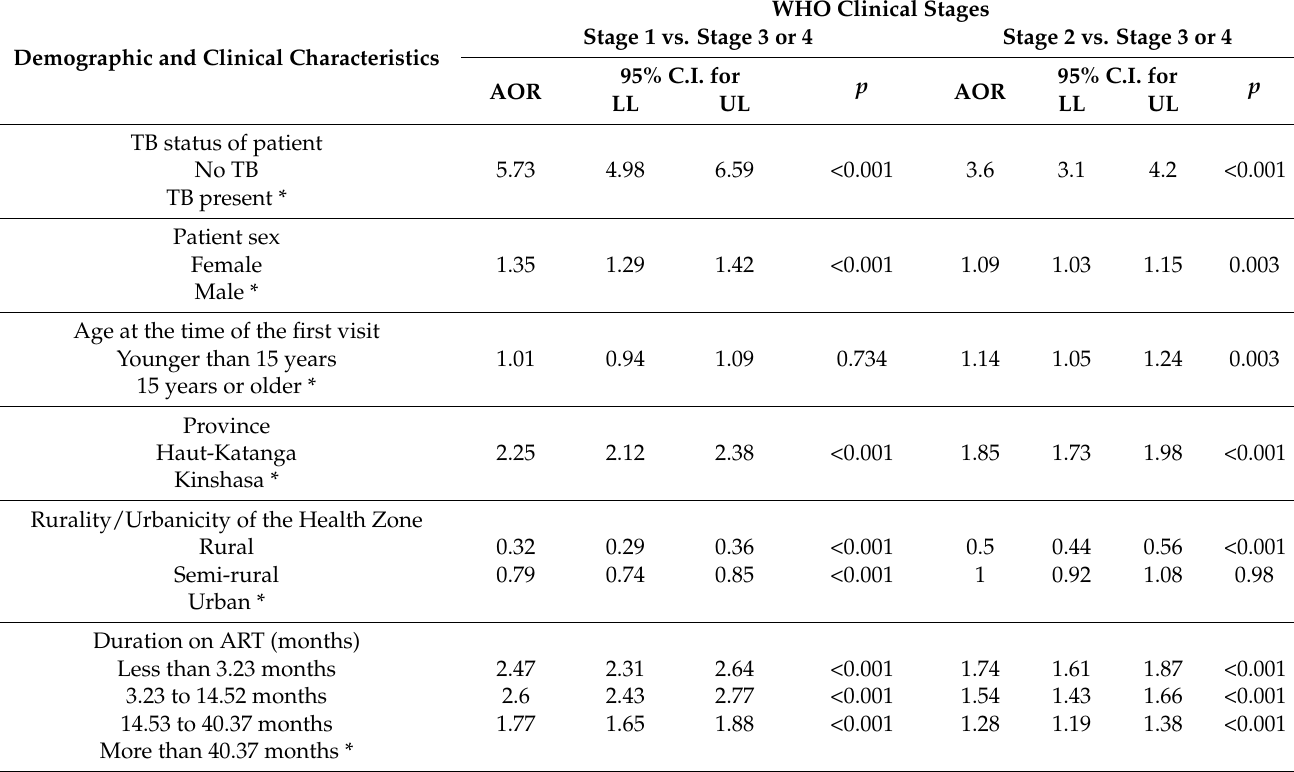
Table 3. Multinomial logistic regression of WHO clinical stage among patients in HIV/AIDS clinics of Haut-Katanga and Kinshasa provinces, Democratic Republic of Congo, 2014–2019.